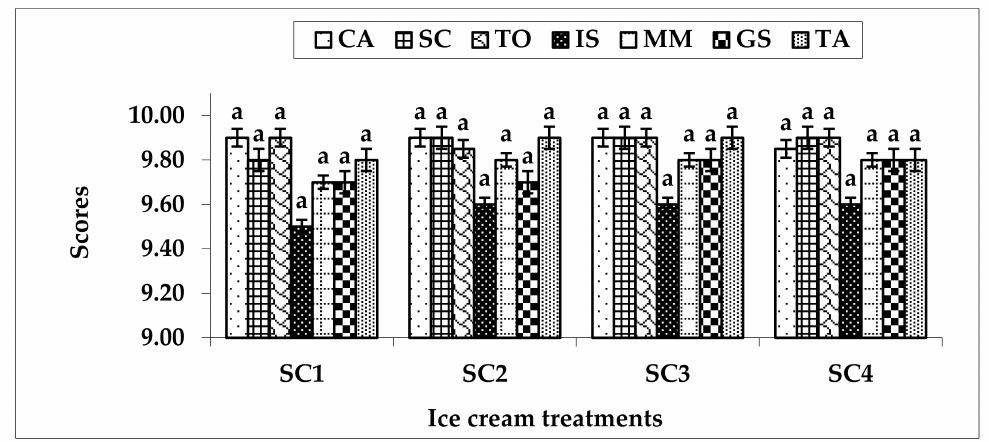
Figure 2. The sensory evaluation of ice cream. CA: color and appearance; SC: structure and con- sistency; TO: taste and odor; IS: icy structure; MM: melt in mouth; GS: gummy structure; TA: total acceptability, SC1: control without artificial sugar; SC2: ice cream with stevia; SC3: ice cream with sucralose; SC4: ice cream with sorbitol; a : bars within the same characteristic not sharing a common letter are significantly different ( p < 0.05).